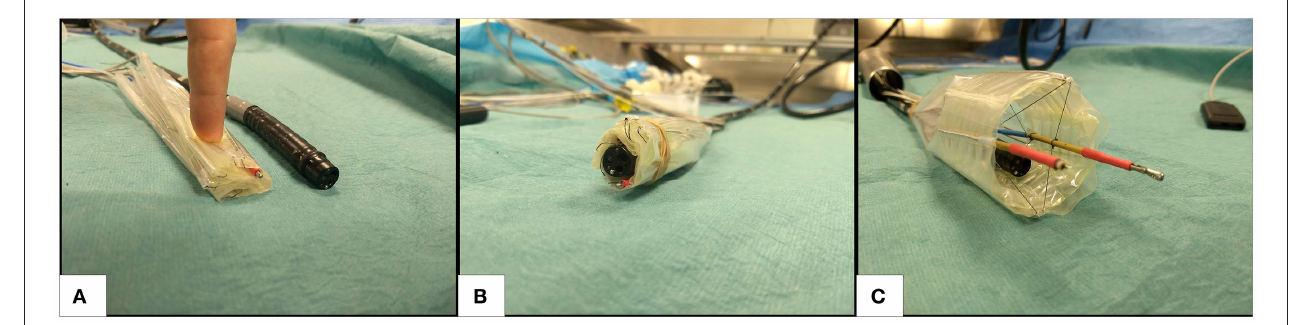
FIGURE 1 | Deployable cable-driven parallel robot (A) folded beside 12mm diameter flexible endoscope (black) (B) undeployed robot placed around flexible endoscope (C) inflatable structure deployed and force-transmission cables pretensioned to allow the two surgical instruments (anchored inside gold and red shafts) to be controlled by changing each cable